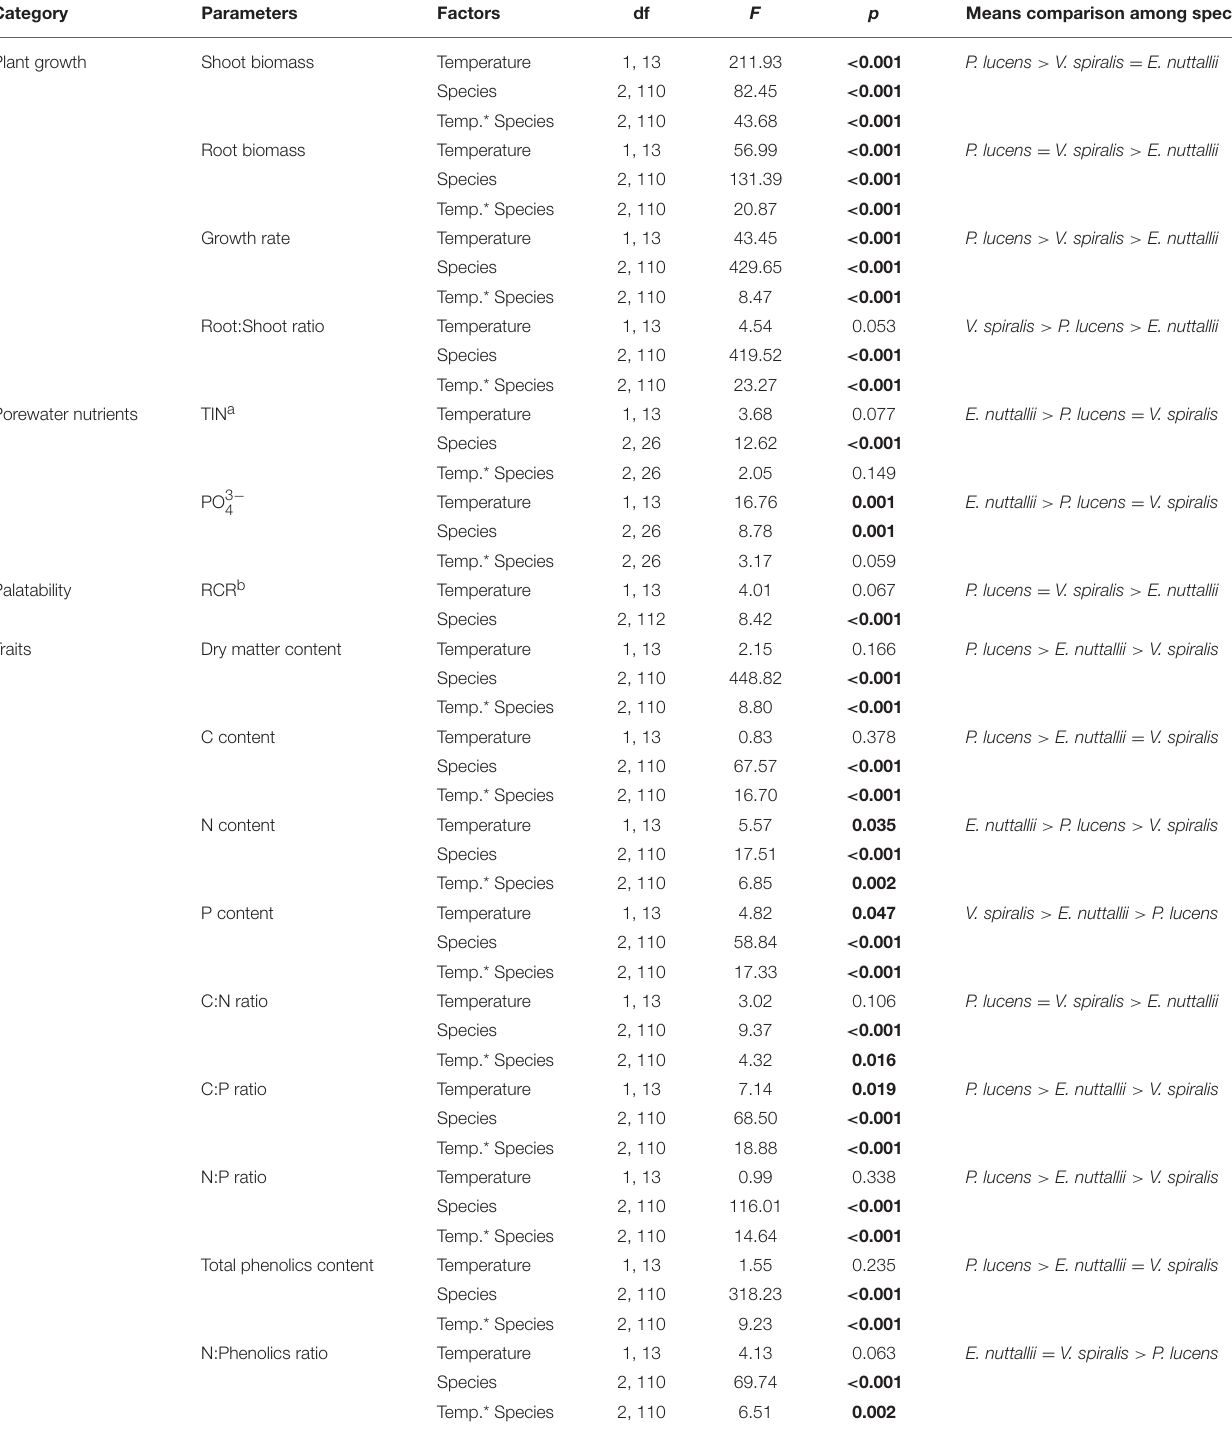
TABLE 1 | Linear mixed-effect model results for the effects of temperature and species on the plant growth and sediment pore water nutrient parameters, plant traits and RCR.